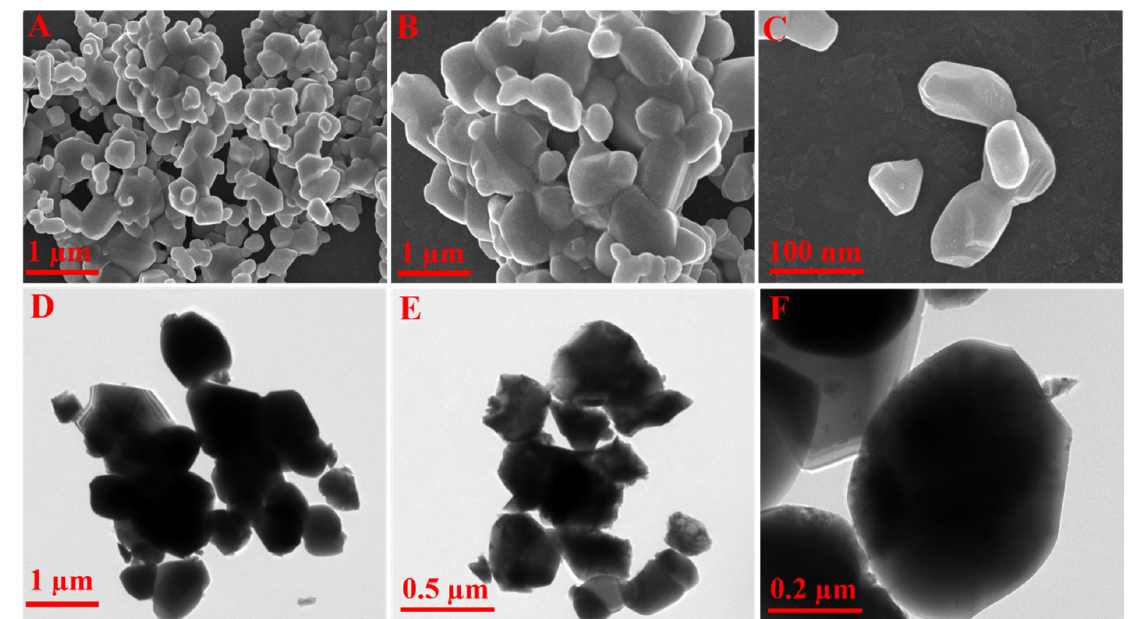
Figure 2. ( A – C ) FE-SEM images of ZTO/TO MPs and ( D – F ) HR-TEM images of ZTO/TO MPs.